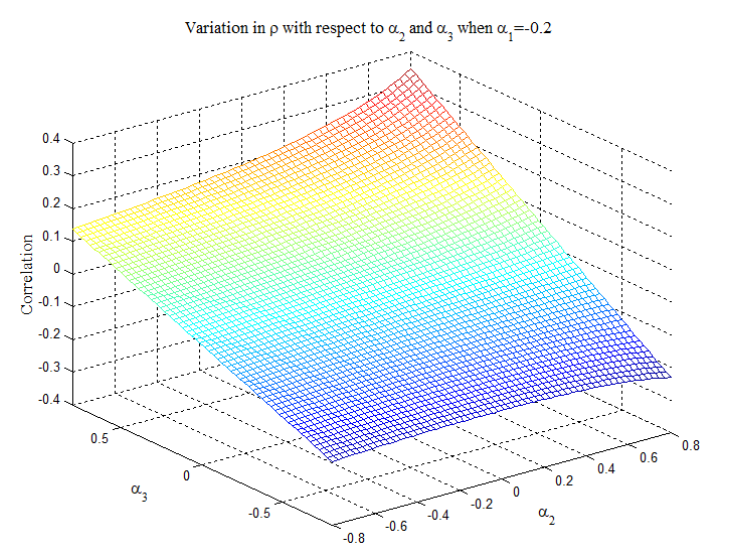
Figure 2 – Correlation w.r.t. α